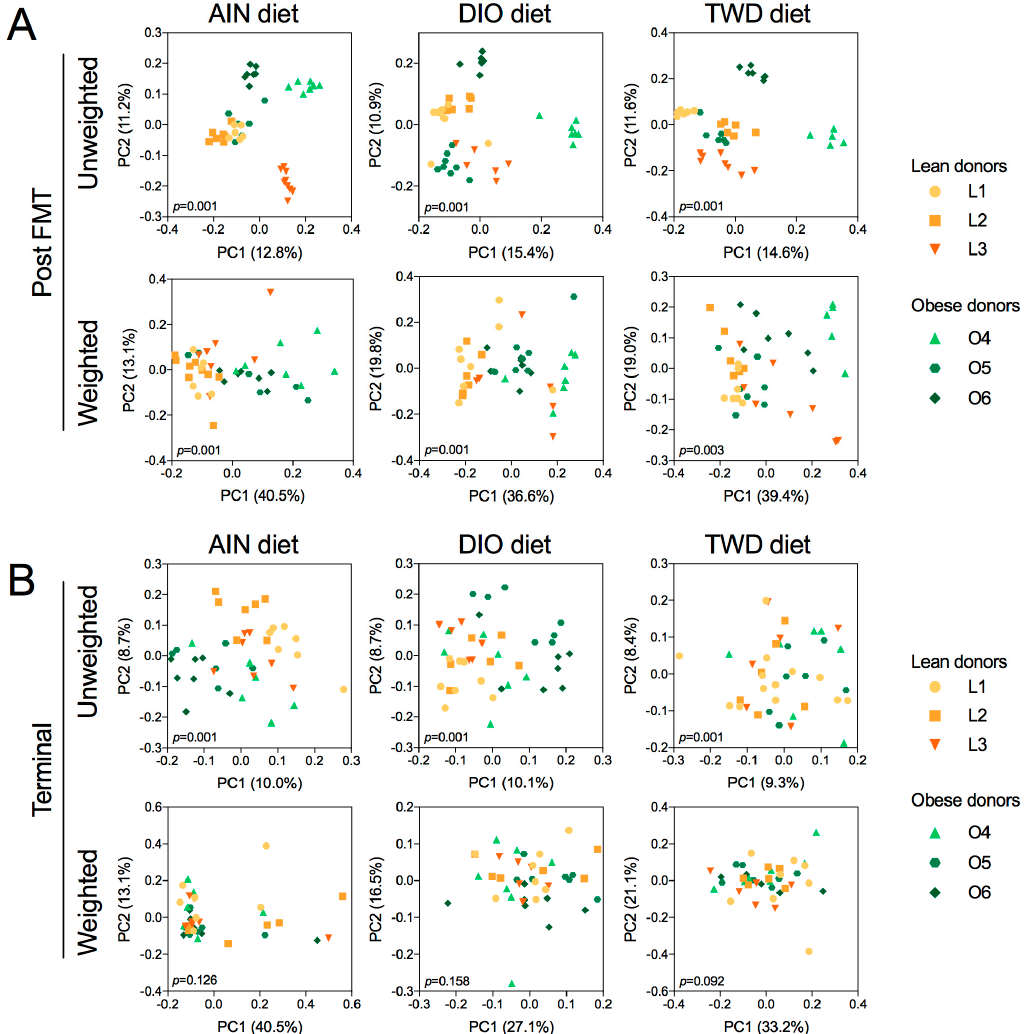
Figure 12. Beta diversity for post-FMT and terminal recipient mouse microbiomes. Data shown are the first two principal coordinates of unweighted or weighted unifrac distances for the post-FMT microbiome ( A ), and the terminal fecal microbiome ( B ). Plots are categorized by human donor body type within each experimental diet. Variation attributed to each coordinate is shown. Permanova p -values are shown for each plot.